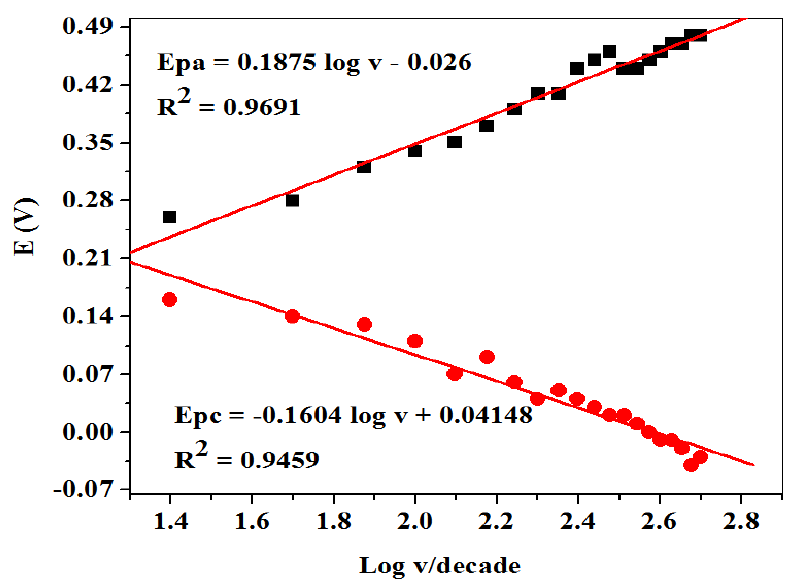
Figure 7. Linear plot of peak potentials (E pa /E pc ) vs. log of scan rate (v/decade) in 0.1 M PBS pH 7.4 containing 5 mM K 3 [Fe(CN) 6 ].